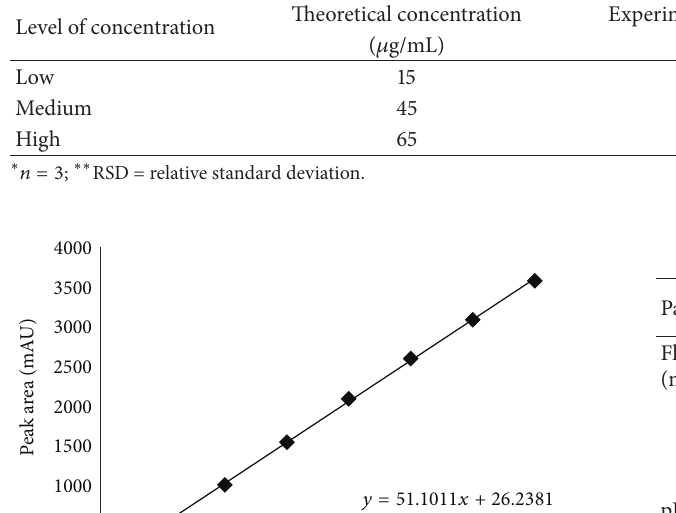
Table 3: Accuracy assays for ferulic acid analysis ∗ .